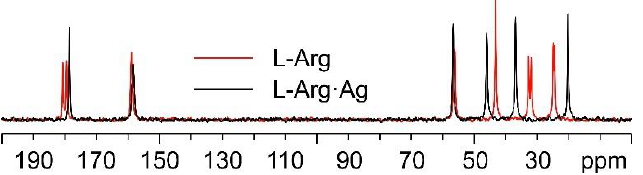
Figure 5. Overlay of the 13 C CPMAS spectra of L-Arg·Ag (in black) and pure L-Arg (in red).